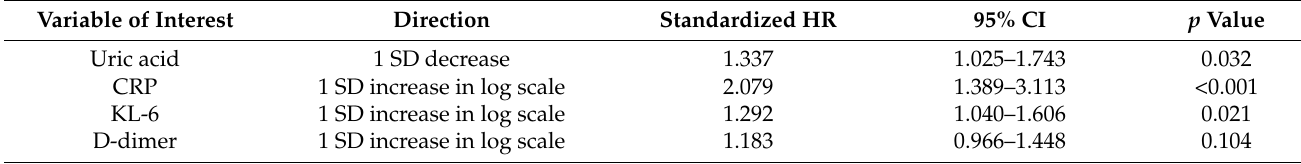
Table 3. Association of markers of inflammation, alveolar damage, and coagulation abnormality at time of admission with progression from non-severe to severe coronavirus disease 2019 (COVID-19).